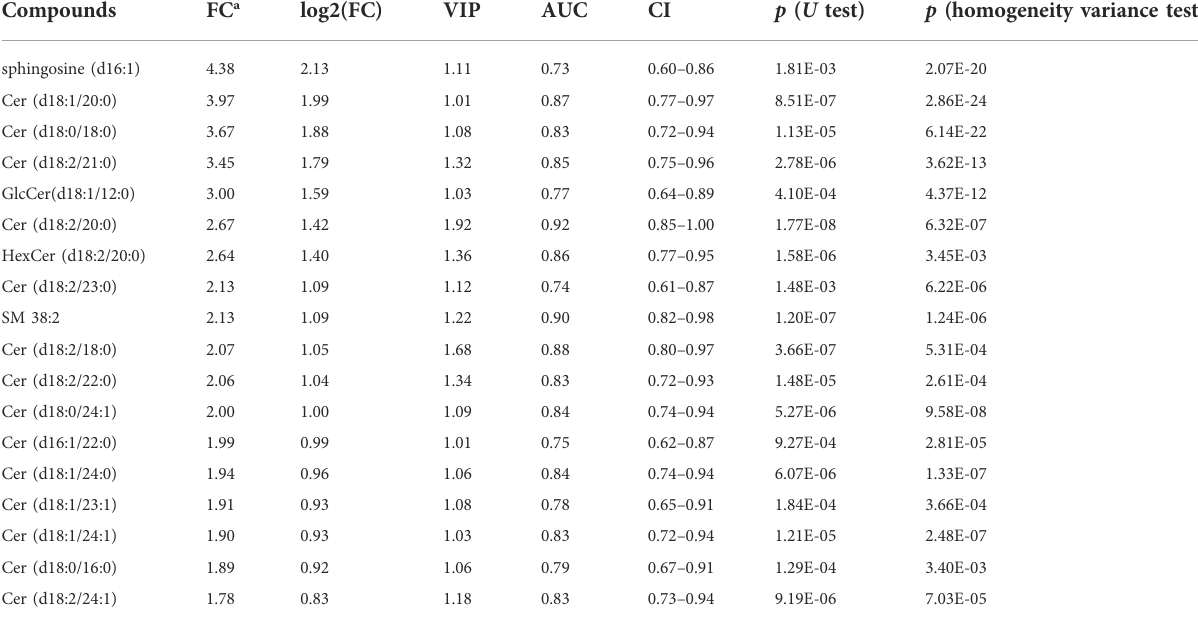
TABLE 2 Differential metabolites in GC tumor tissue when compared to adjacent tissue. Compounds FC a log2(FC) VIP AUC CI p ( U test) p (homogeneity variance